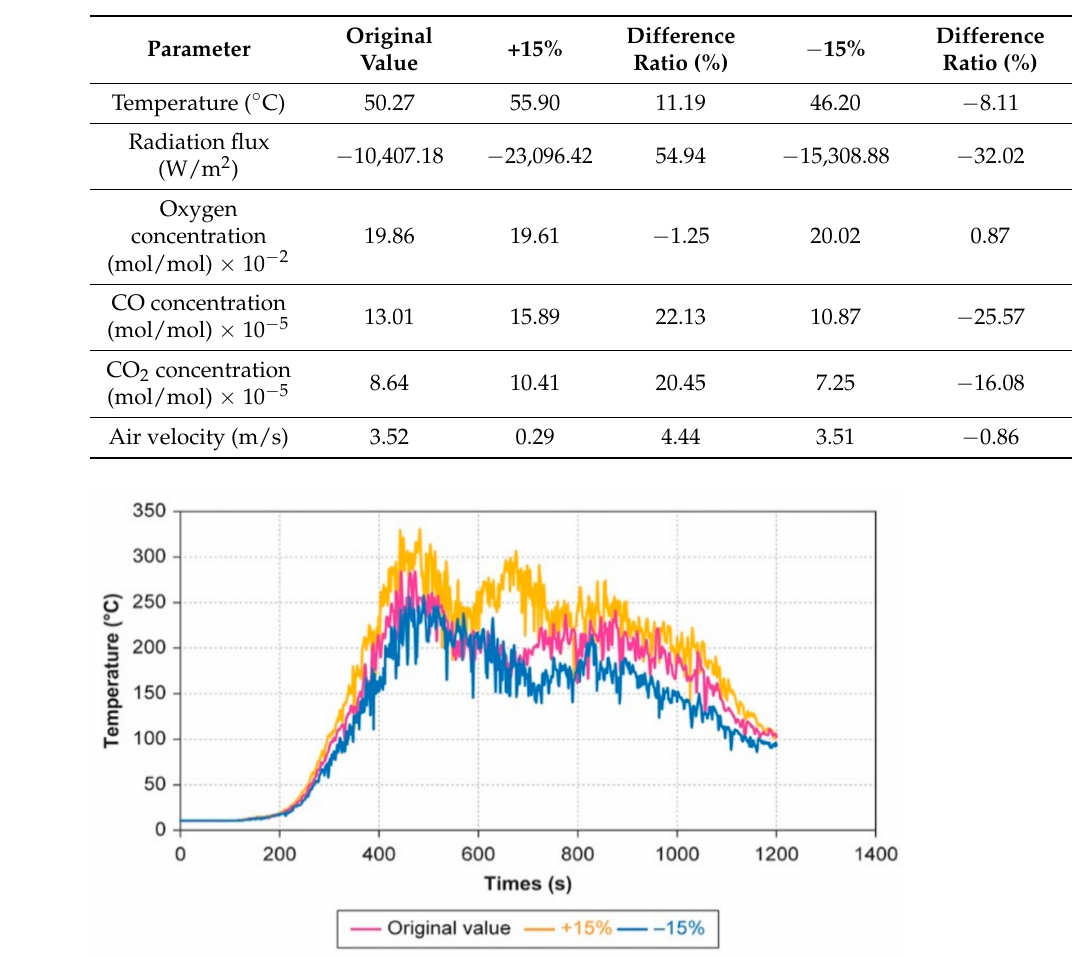
Table 7. Effects of HRRPUA.